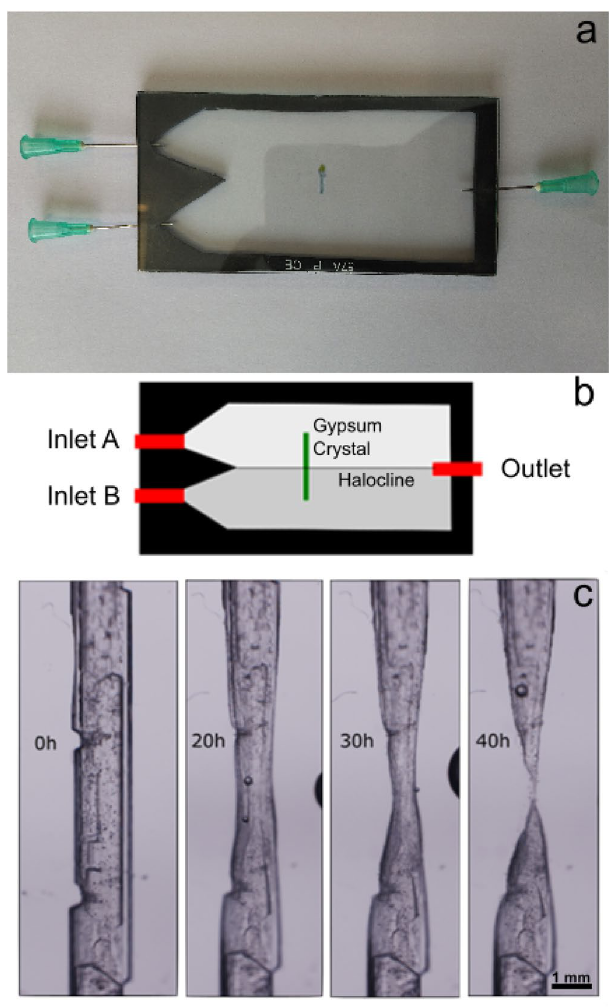
Figure 5. Actual view ( a ) and schematic representation ( b ) of the halocline flow setup. Inlets and outlet are marked in red; the rubber separator is shown in black. The green segment represents the position of the gypsum crystal inside the flow chamber. The white and grey areas represent the space filled with both solutions. ( c ) time- lapse images of the dissolution of the gypsum crystal at the halocline of the first experiment between solutions 1 M and 5 M of NaCl. The interface between both solutions is at the vertical centre of the images. The original video can be found in Supplementary Video